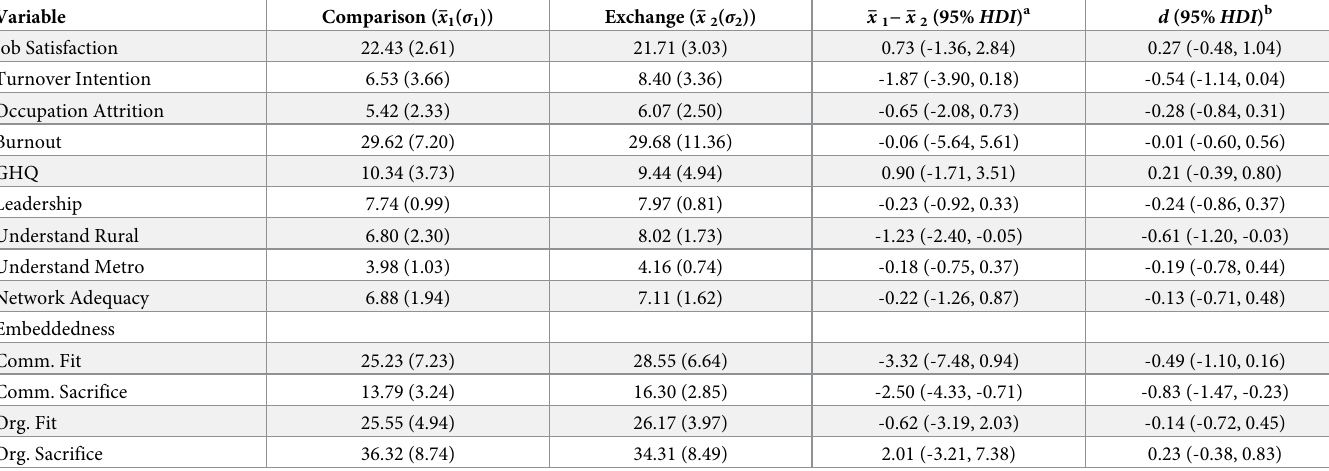
Table 3. Mean differences and highest density intervals for comparison and exchange group differences (n =